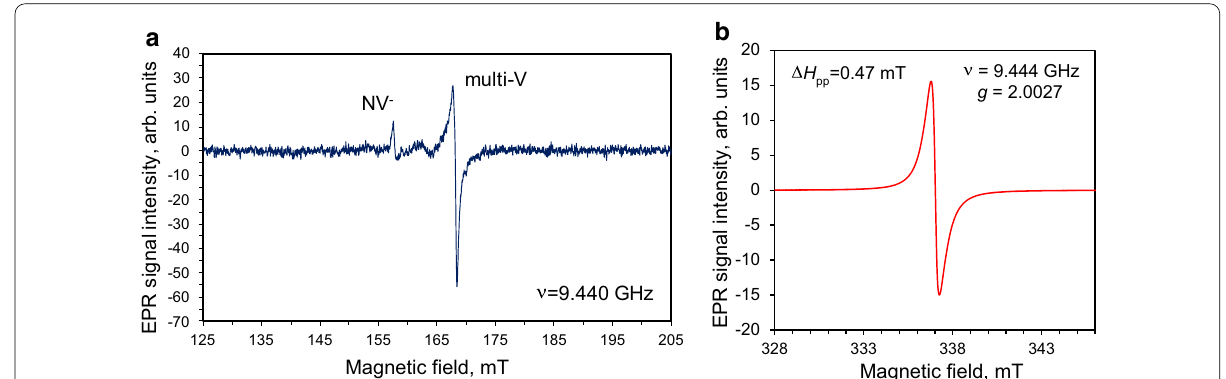
Fig. 6 EPR spectra of the DP 0–0.05 fraction of diamond particles in the half magnetic field range ( a ) and around the resonant magnetic field of the singlet with strong signal at g -factor g 2.0027 ( b ). Microwave power P MW : 10 mW ( a ) and 0.03 mW ( b ). Microwave frequency ν ≈ spectra are registered in the regime far from